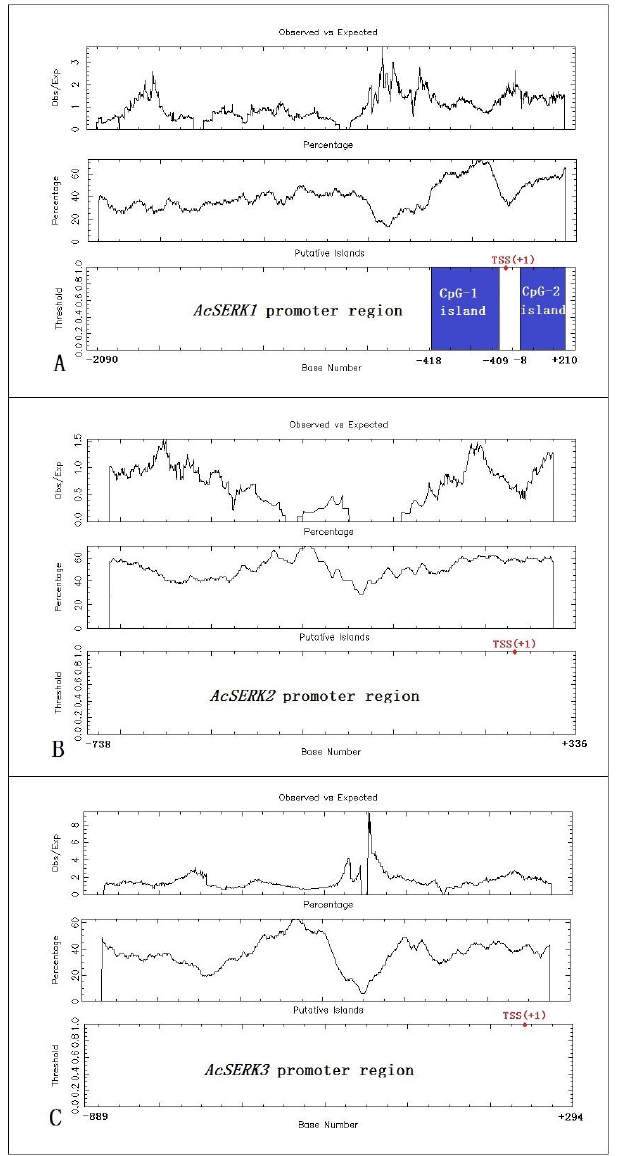
Figure 1. Bioinformatics prediction of CpG islands in the promoter regions of three AcSERKs . (A) The AcSERK1 promoter region contains two CpG islands, which are indicated in blue. (B,C) The bioinformatics prediction results of CpG islands in the AcSERK2 and AcSERK3 promoters, respectively. Neither is predicted to contain CpG islands. The Cpgplot program defines a CpG island as a region corresponding to the following parameters: Observed / Expected ratio > 0.60, Percentage C + Percentage G > 50.00, and Length > 200. The transcription start site is represented by TSS (red dot), and this site is defined as +